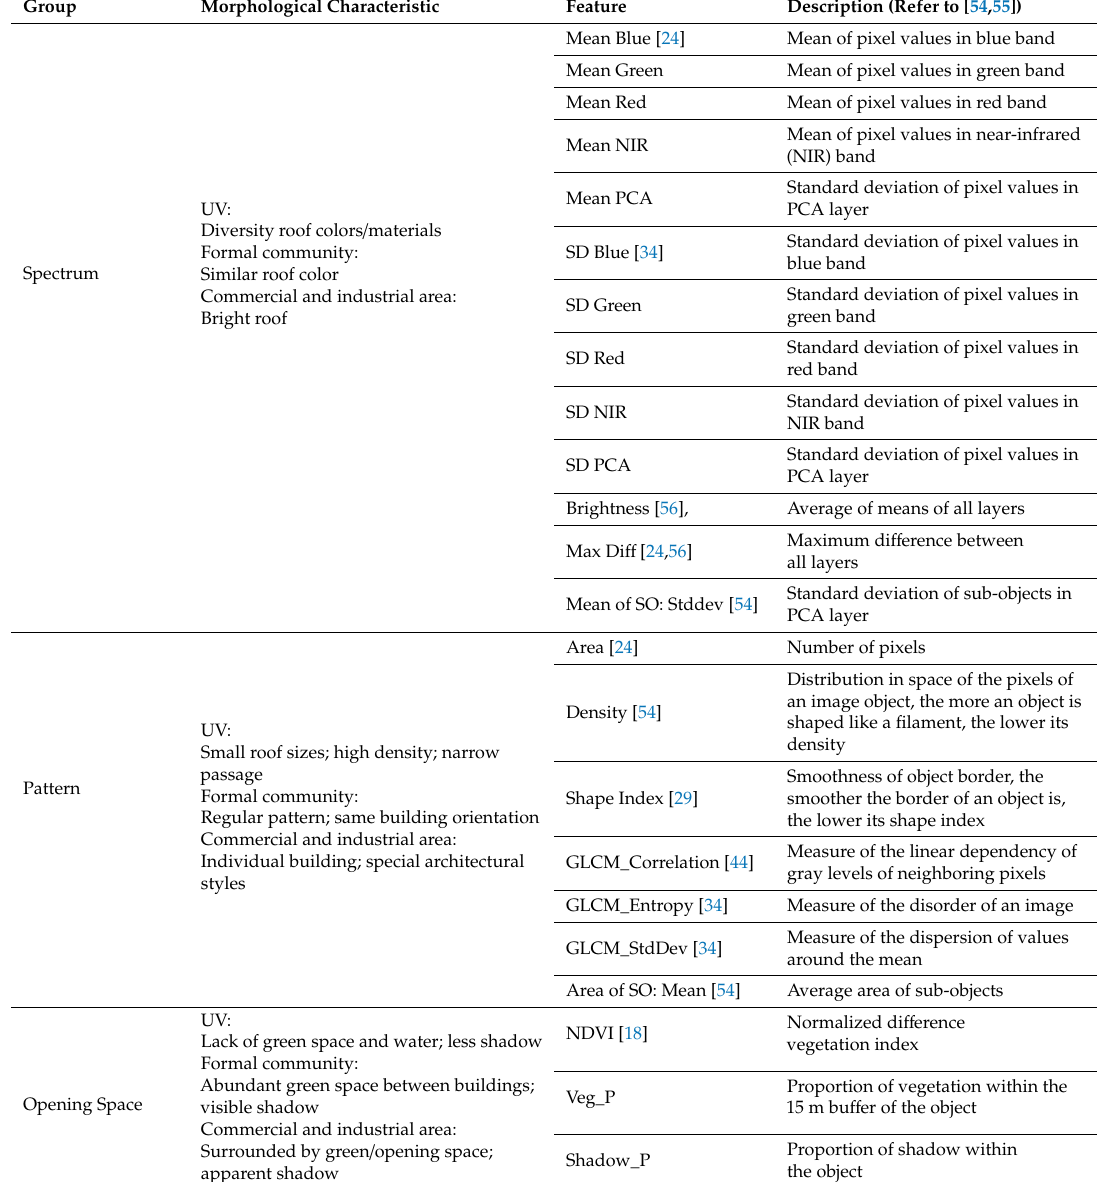
Table 1. Feature selection based on morphological